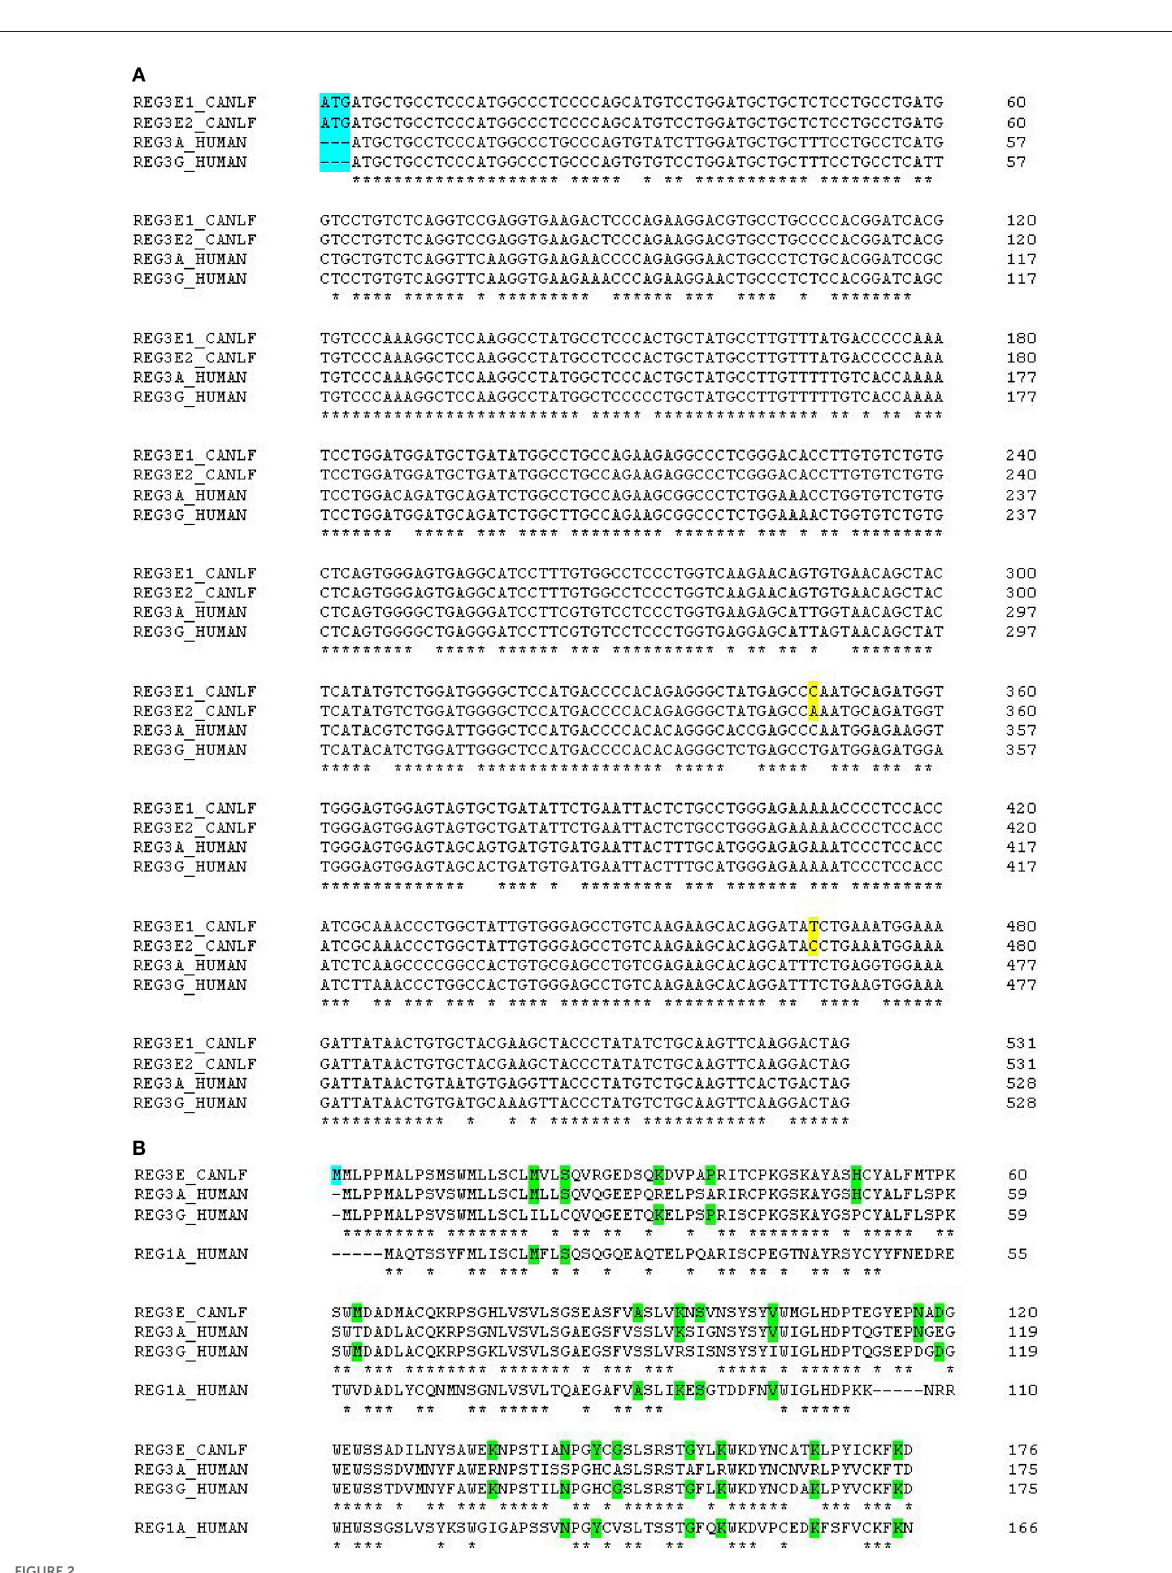
FIGURE2 (A) Multiple alignments of canine and human REG3 genes. Note the additional start codon in dogs, immediately before the start codon in the human genes (highlighted in blue). The two differing nucleotides between canine REG3E1 and REG3E2 are highlighted in yellow. Canine